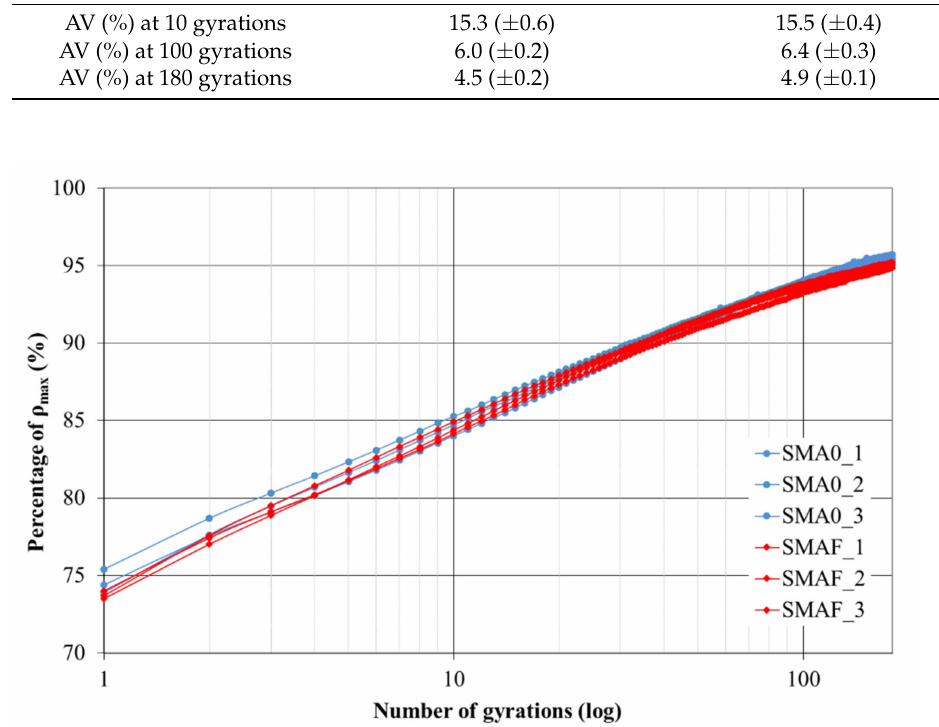
Figure 3. Bituminous mixtures gyratory compaction